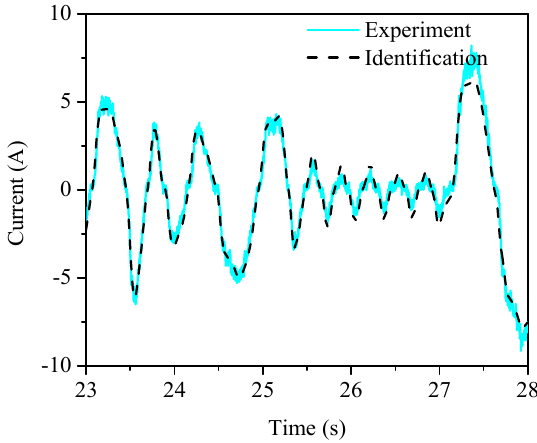
Figure 21. Verification of the identified EPS system.